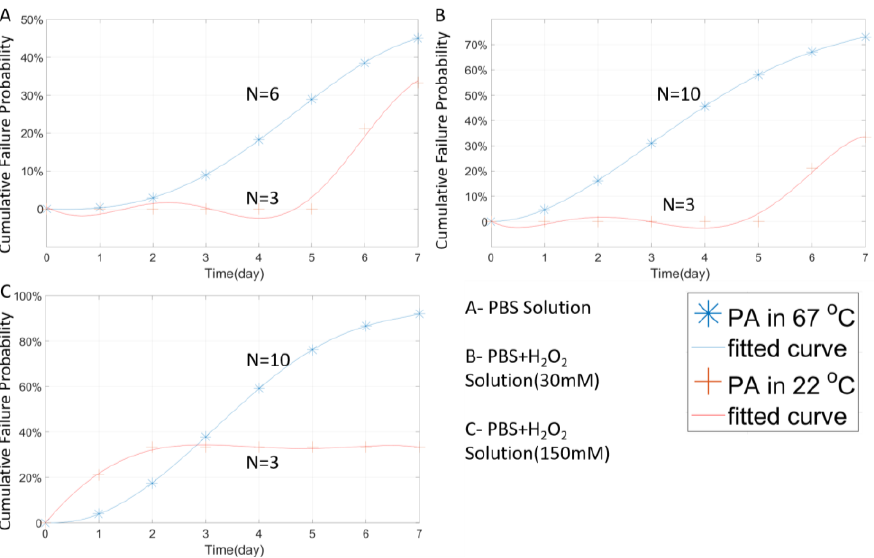
Figure 4. The Weibull cumulative distribution data and corresponding curve fitting of the closed-tip samples coated with 3 µm stacked-deposition of PA, measured at two temperatures of 67 °C or 22 °C in different solutions.